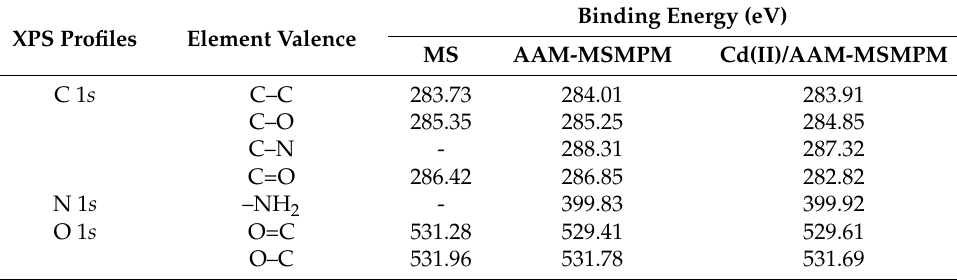
Table 1. Binding energies of the core electrons of the MS, AAM-MSMPM, and Cd(II)/AAM-MSMPM.